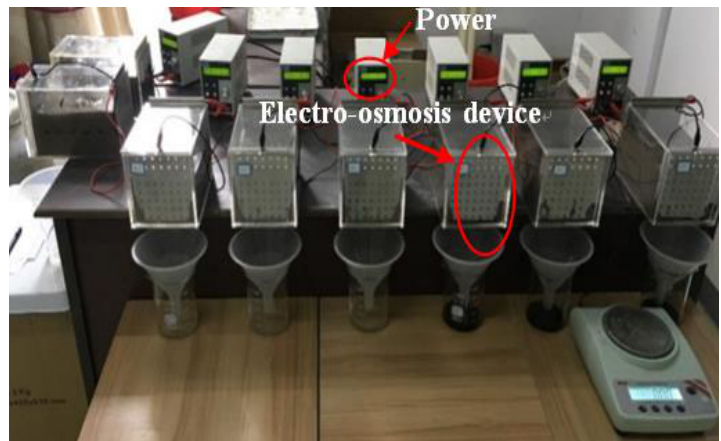
Figure 2. Setup of electro-osmosis test.